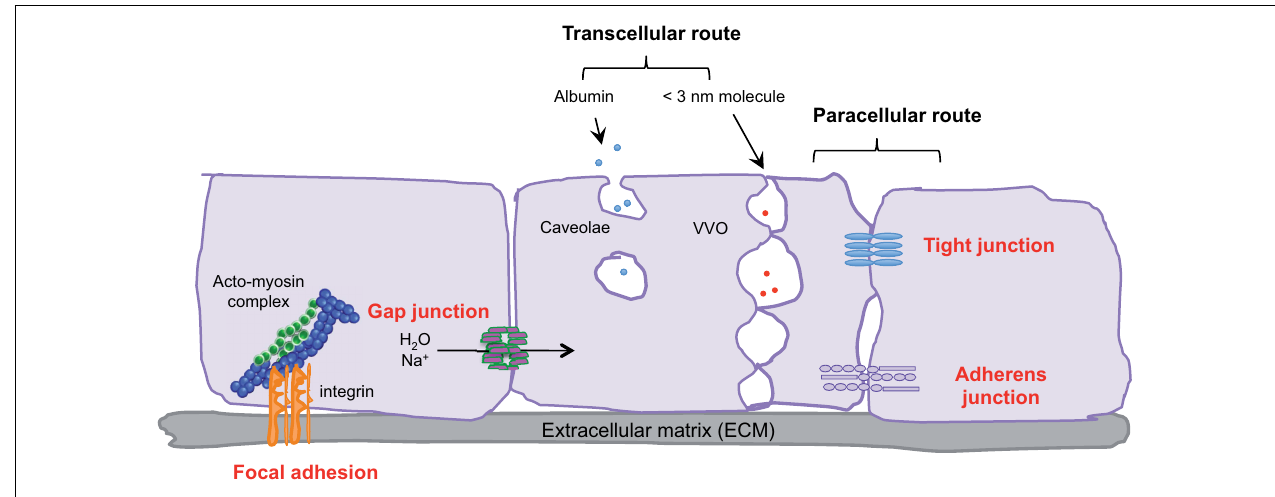
FIGURE 1 |Transcellular and paracellular pathways in endothelial cells .The passage of cells and macromolecules through the endothelial barrier can occur through transcellular (vesicular vacuolar organelles) or paracellular (tight and adherens junctions) pathways. Gap junctions ensure water and ion transport. Moreover, endothelial cells are anchored and connected to the extracellular matrix (ECM) through integrin-based adhesion complexes, namely focal adhesions.